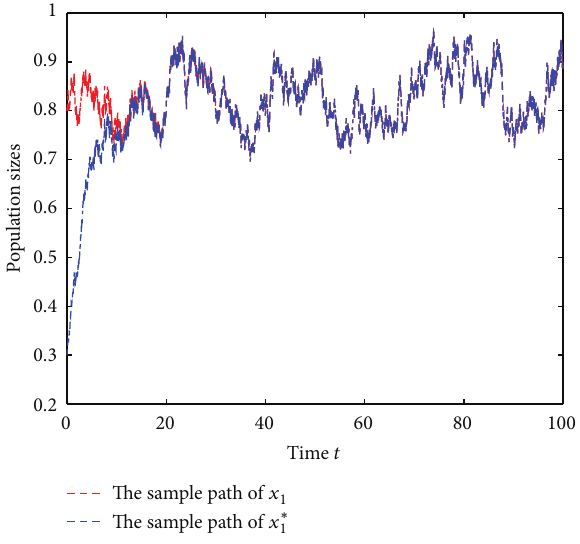
Figure 1: The sample paths of 𝑥 1 (𝑡) and 𝑥 ∗ 1 (𝑡)